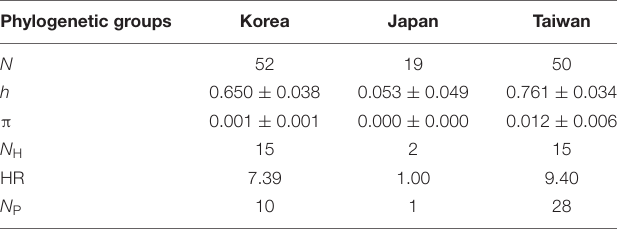
TABLE 1 | Summary of the levels of genetic diversity in three phylogenetic groups of Alveopora japonica from Korea, Japan, and Taiwan at the nuclear ribosomal internal transcribed spacer (ITS) region (668 bp).